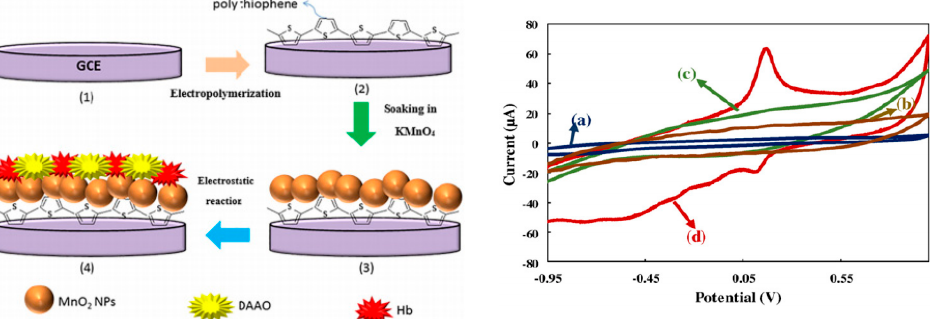
Figure 7. Left : Fabrication steps of the DAAO-Hb/MnO 2 NPs/PTh/GCE bi-enzyme biosensor. Right : CVs of ( a ) bare GCE, ( b ) PTh/GCE, ( c ) MnO 2 NPs/PTh/GCE and ( d ) DAAO-Hb/MnO 2 NPs/PTh/GCE in PBS solution (100 mM, pH = 6) containing 200 μ M D -alanine and 5 μ M DAAO at scan rate of 100 mV/s. Reprinted with permission from reference [60]. Copyright 2017 Elsevier.